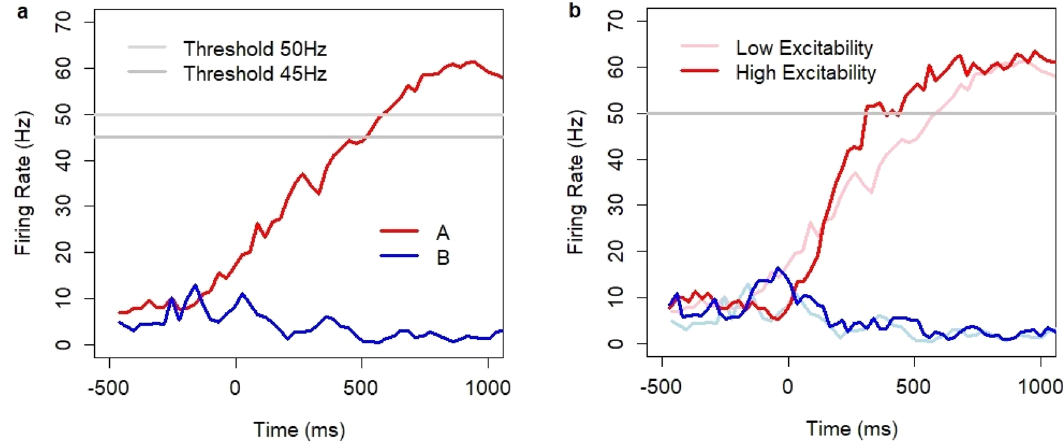
Figure 3. Modulation of the decision threshold ( a ) and the excitability level ( b ) and the effect on the neuronal integration process performed by the attractor network with decision pools A and B, which encode the categorical